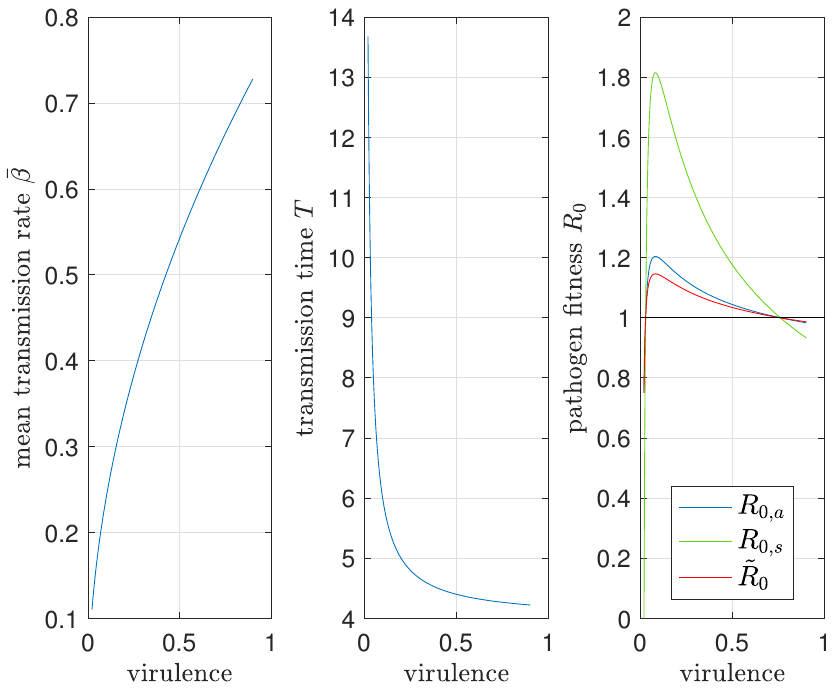
Figure 4. Plots with respect to virulence q γ (probability of dying due to disease symptoms). Left (cid:113) q γ panel: mean transmission rate ¯ β = —see (13). Center panel: transmission time T = 1 pc days. Right panel: basic reproduction numbers as in Figure 3 but as functions of virulence. Optimal virulence q γ ∗ = 0.08 for the maximization of reproduction numbers. Parameter values as in Figure